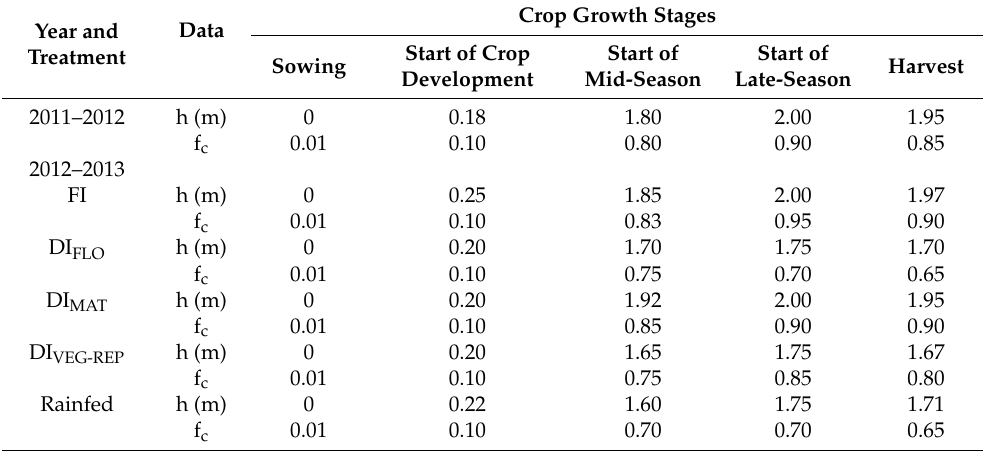
Table 4. Crop height (h) and fraction of ground covered by the crop (f c ) at the main crop growth stages. Year and